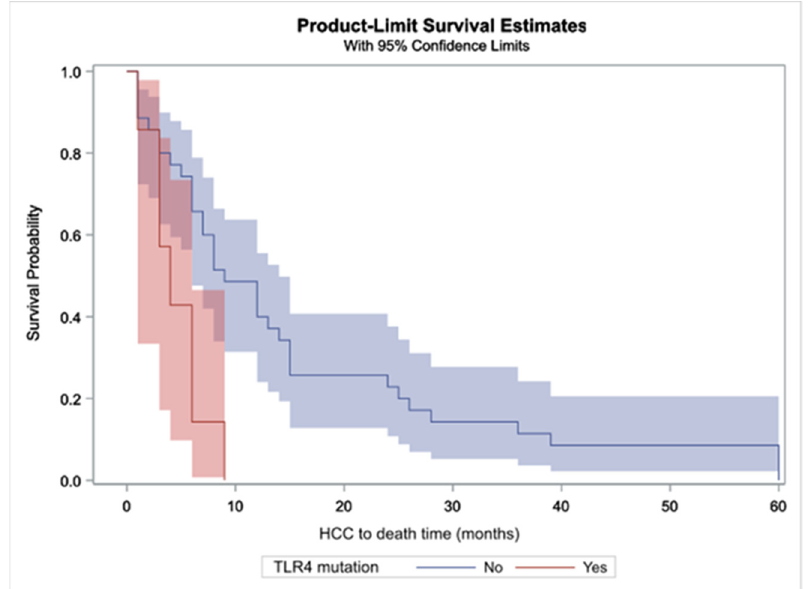
Figure 1. Survival curves for the patients with HCC in relation to TLR4 mutations. Shaded area indicates the 95% confidence interval.